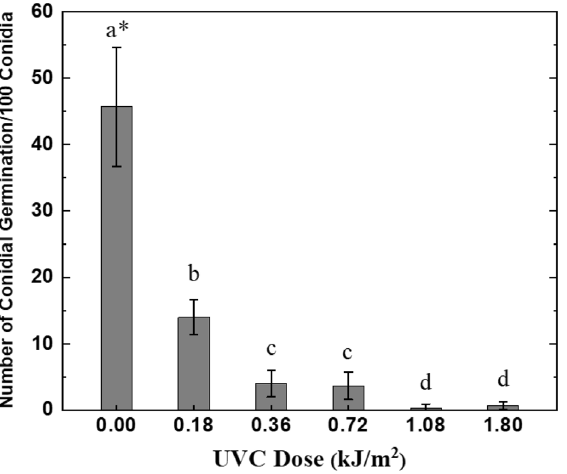
Figure 10. The statistical number of conidial germinations at different UVC doses (* means within each column followed by the same letter are not significantly different at the 5.0% level according to LSD).